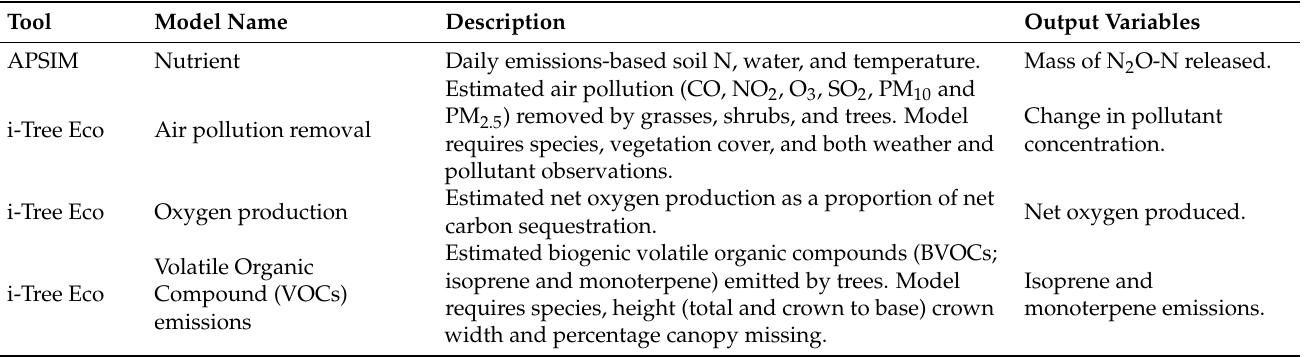
Table 5. Summary of the shortlisted tools and associated models that quantify air quality and